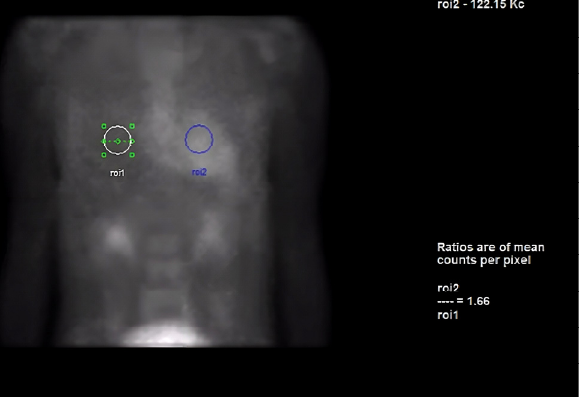
Figure 4. SPECT in an ATTR cardiac amyloidosis patient. Evidence of uptake of 99m Tc-PYP in the myocardium. ( a ) Quantitative SPECT/CT; ( b ) Semiquantitative analysis of 99m Tc-PYP myocardial uptake.